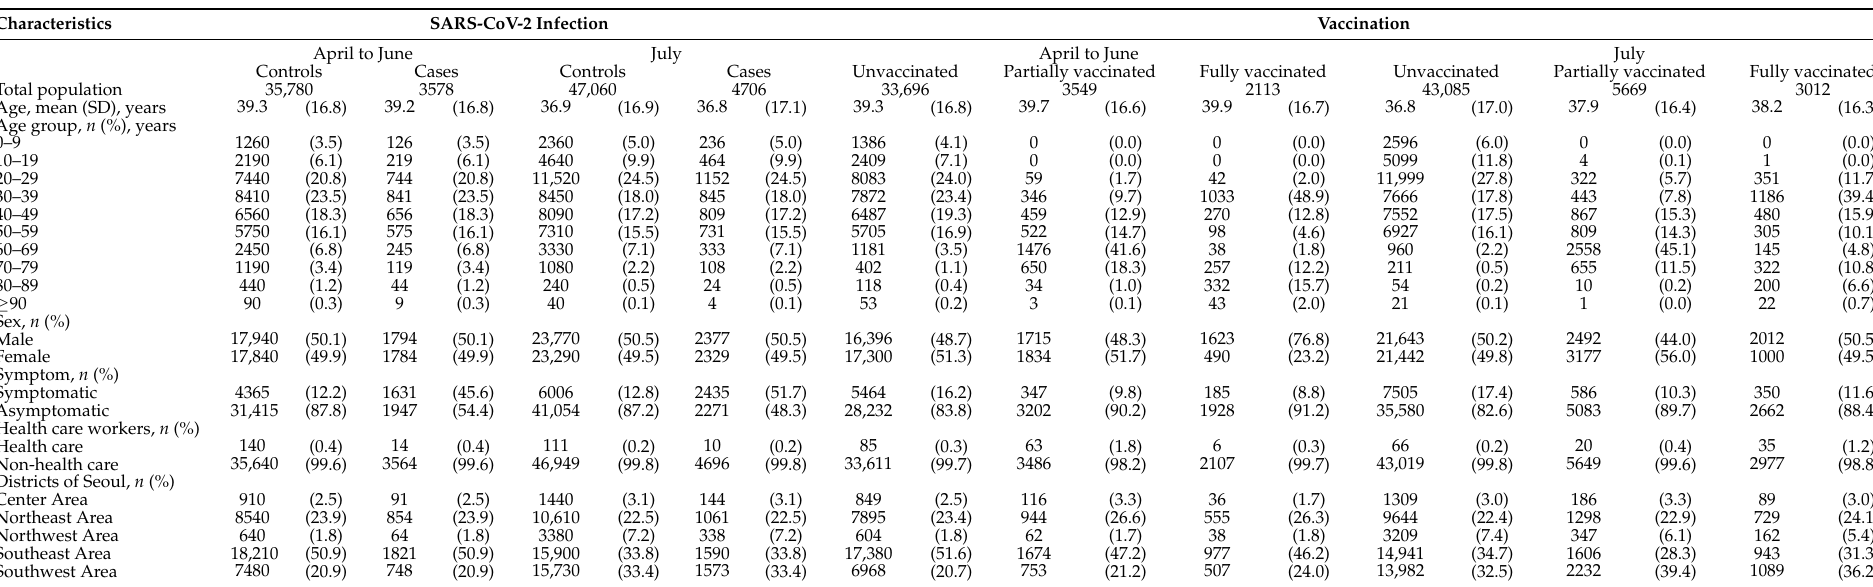
Table 1. Comparison of the characteristics of the study population according to SARS-CoV-2 infection (detected by RT-PCR) and COVID-19 vaccination statuses. Characteristics